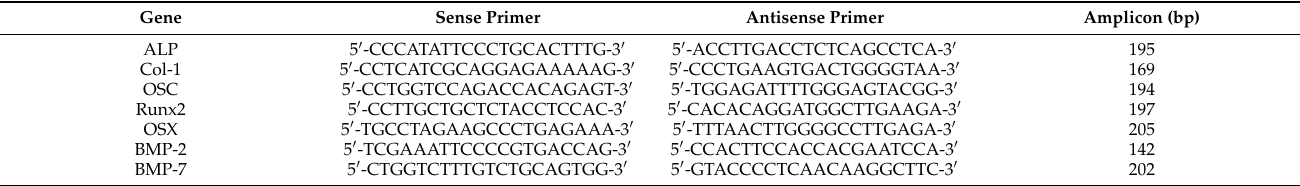
Table 1. Primer sequences for the amplification of cDNA by real-time